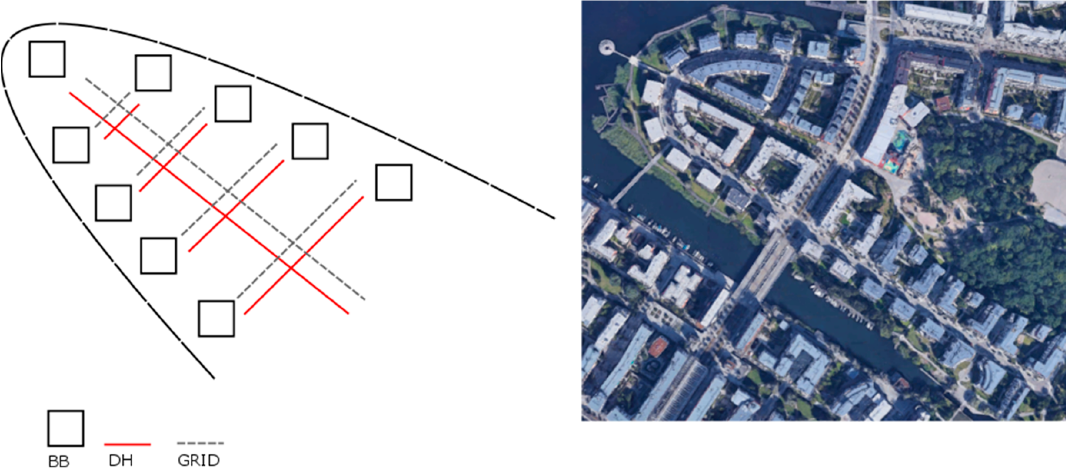
Figure 1. The case study area: a conceptual illustration and a satellite view BB: building block; DH: district heating.